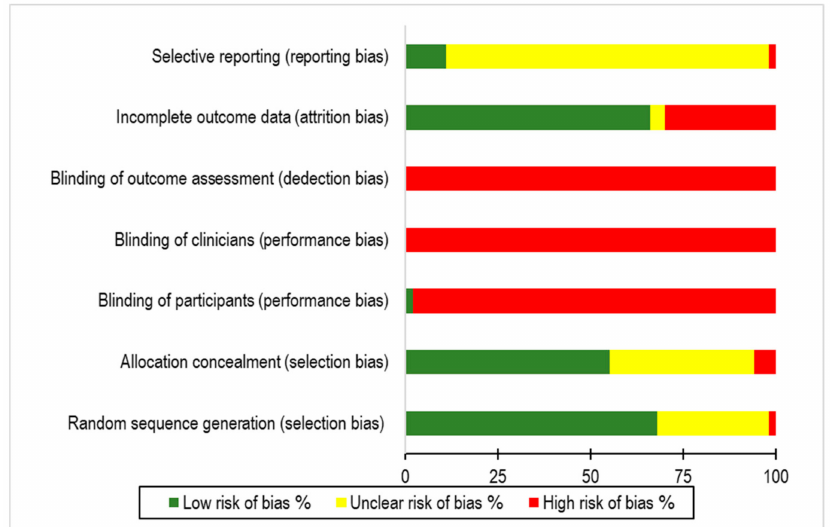
Figure 1. Risk of bias graph: assessments for seven risk of bias criteria presented as percentages across all included